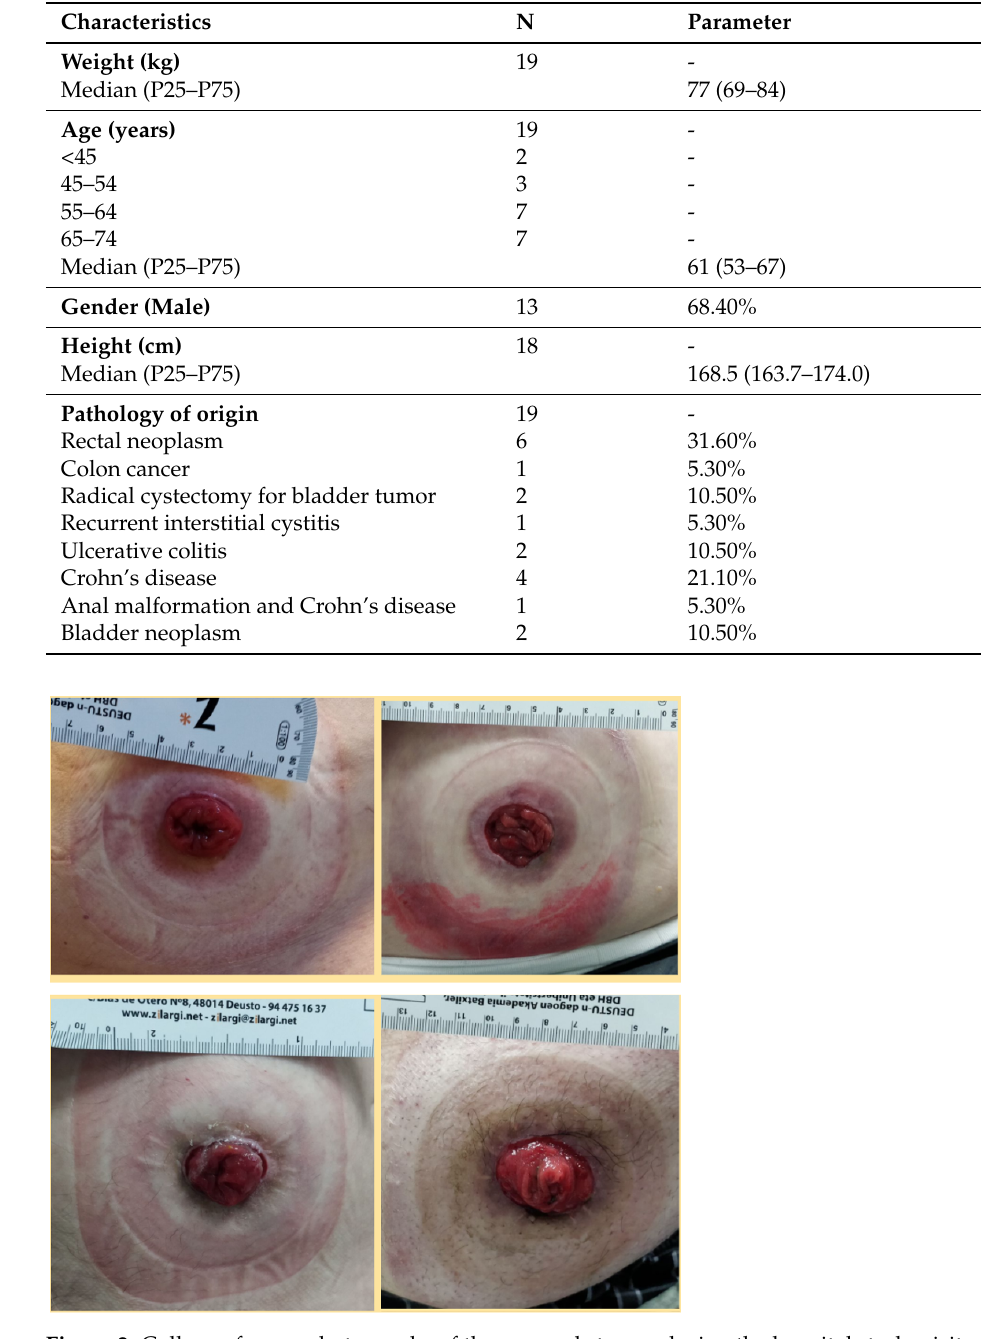
Figure 2. Collage of some photographs of the scanned stomas during the hospital study